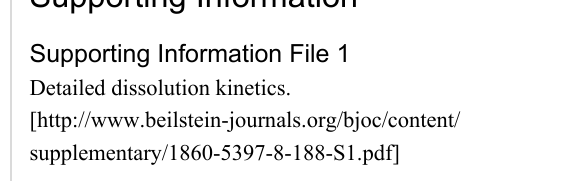
with 6 mM γ -CD thioether, and then the obtained inclusion complex dissolved in water after evaporation of the